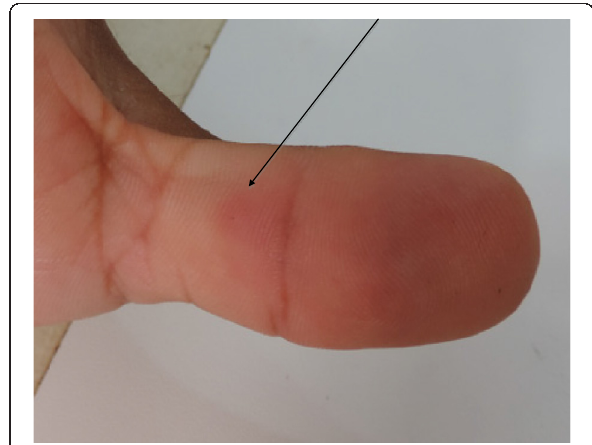
Figure 2 Scorpion sting site on the middle of the thumb 56 hours after the accident.